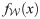
The probability density functions fW(x) of the weight W of a link (a) and fS(x) of the strength S of a node (b) in network G2 (blue points) and G3 (red points).Horizontal and vertical axes are presented in logarithmic scale. The horizontal axis is split into 20 bins, each with the same bin size in the linear scale. The probability density fW(x) (fS(x)) at a given bin x is equal to the fraction of the links (nodes) whose weight (strength) falls within the bin normalized by the bin size. Both link weight and node strength have, respectively, a higher average in G3 and higher coefficient of variation (the ratio of standard deviation over the average) in G2.